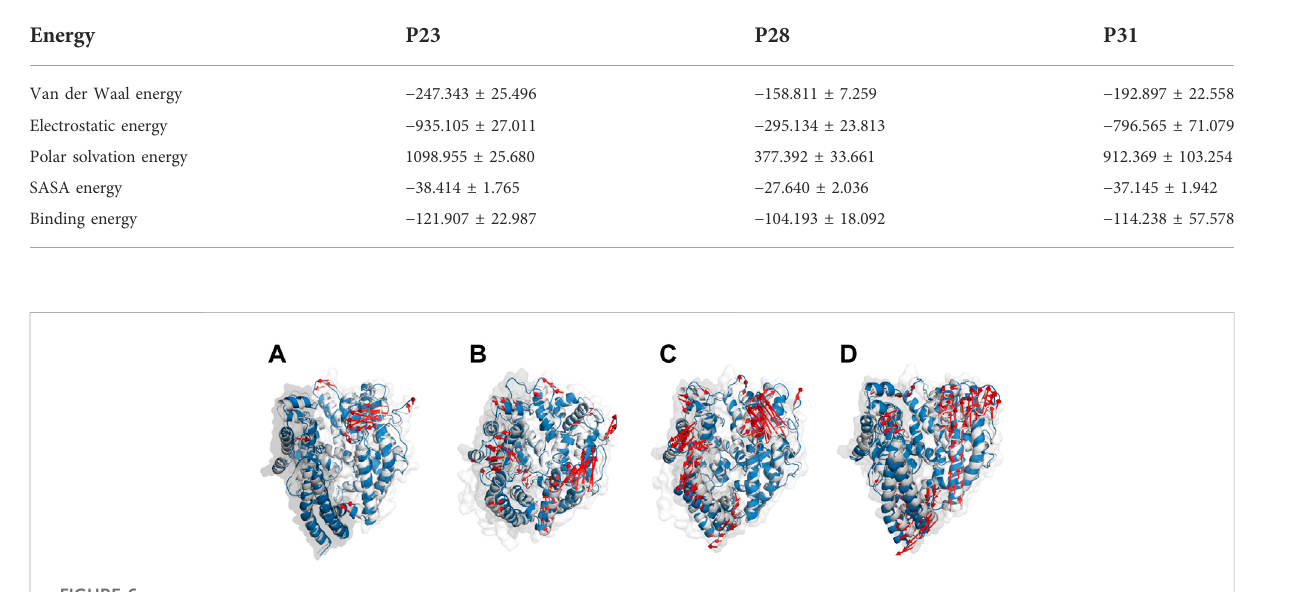
TABLE 4 The mmpbsa analysis of designed peptides ’ binding.